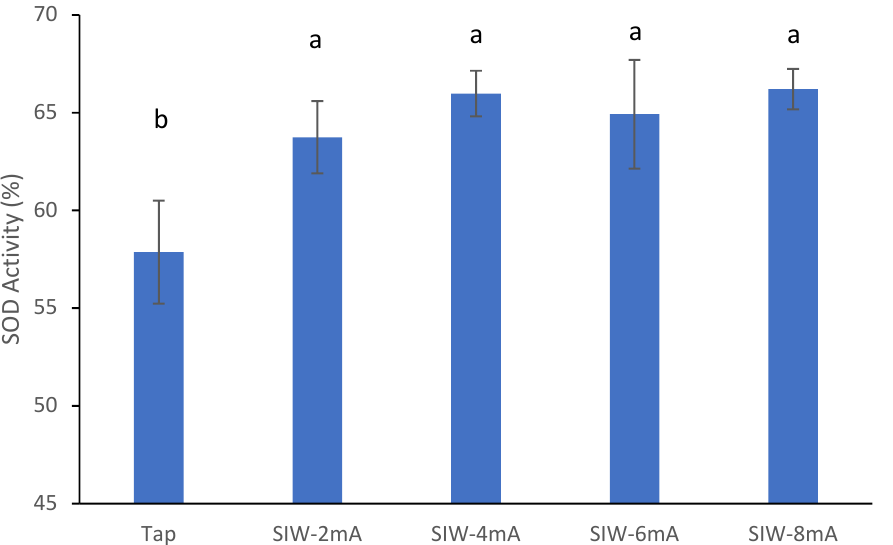
Figure 1. SOD activity of SIW solution with different concentrations. SIW-x mA, the electrolytic current of x mA for silver-ionized water (x = 2, 4, 6, 8). All sample solutions in this study contained 2 mmol/L AsA. Different letters indicate significant difference ( p < 0.05). Each value is expressed as the mean value ± standard deviation of three replicates.